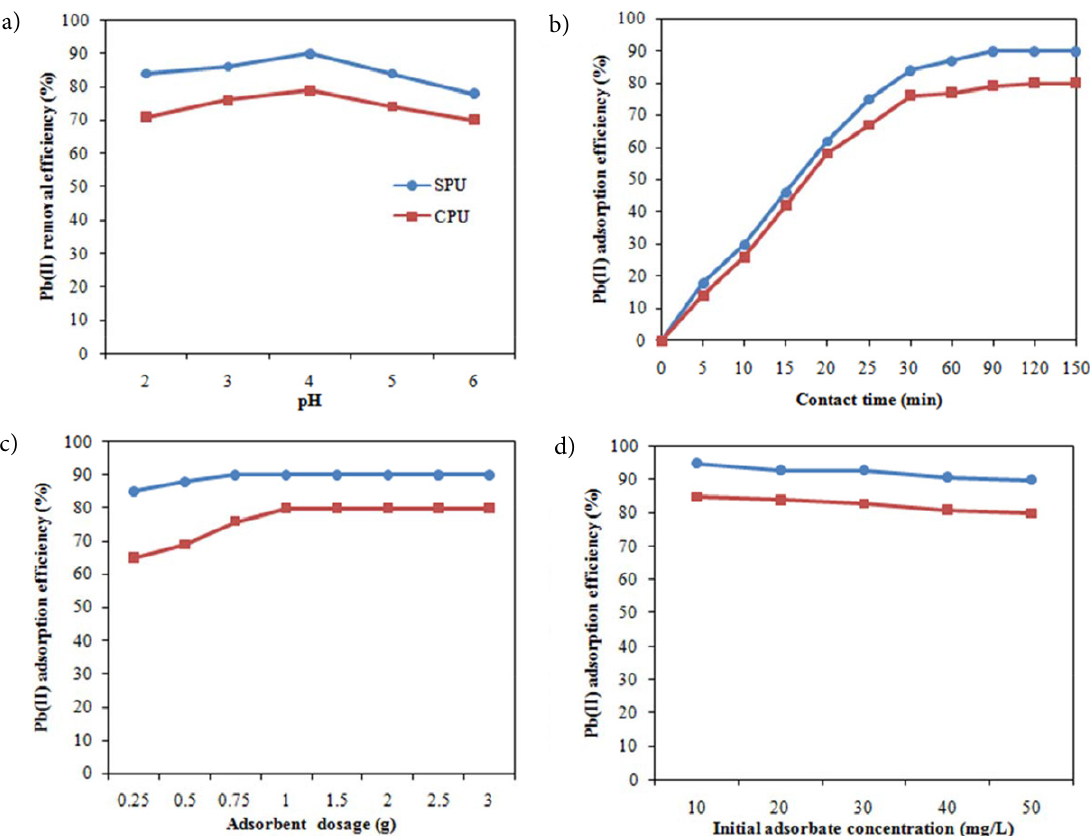
Figure 1. Effect of (a) pH, (b) contact time, (c) adsorbent dosage and (d) initial adsorbate concentration on Pb (II) ion removal efficiency using SPU and